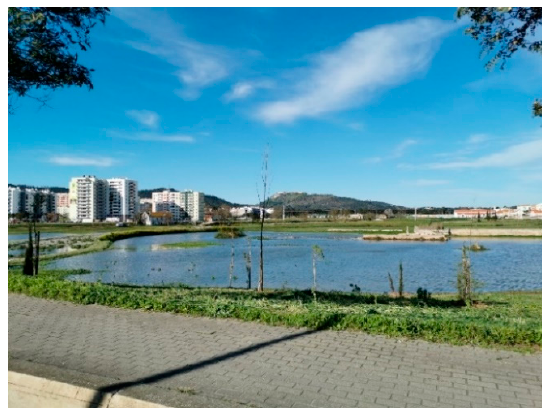
Figure 7. One of the artificial lagoons of the Varzea Urban Park (VUP) (location in Figure 1).